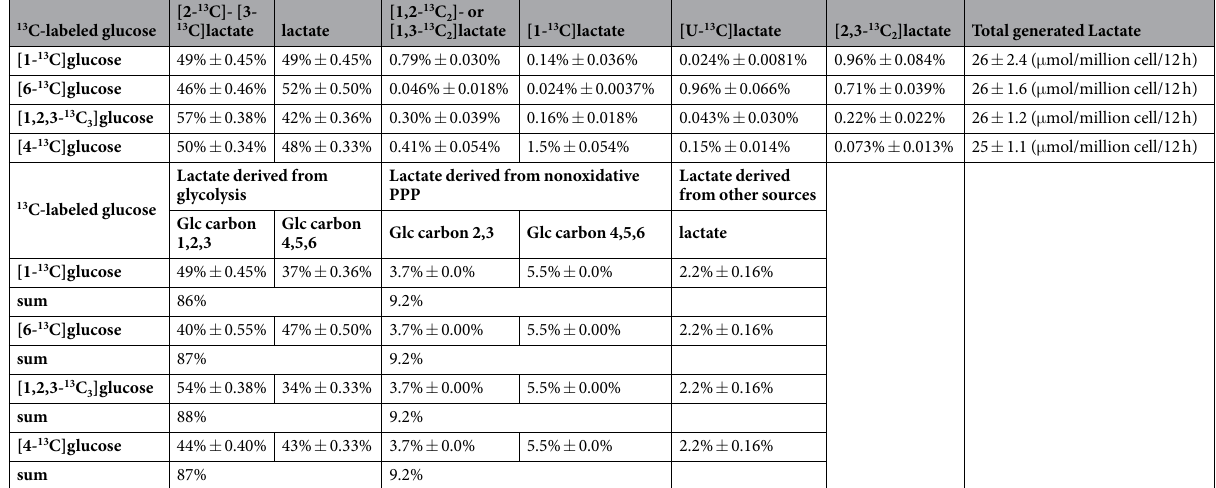
Table 4. The percentage of lactate isotopomers and isotopologues (mean ± SD, n = 12) generated by 4T1, traced by [1- 13 C]-, [6- 13 C]-, [1,2,3- 13 C 3 ]-, and [4- 13 C]glucose (upper part), the percentage of lactate (mean ± SD, n = 12) derived from glycolysis, PPP and other sources (down part). 4T1 cells were incubated in serum-free in a humidified CO 2 incubator and culture supernatant was collected for LC-MS/MS analysis as described in Materials and Methods. The upper part summarizes the percentage of all lactate isotopologues. The down part assigned the percentage of isotopologues that are generated from glycolysis, pentose phosphate pathway, and other sources. Specifically, the percentage of lactate is composed of three parts, from glycolysis, pentose phosphate pathway (calculated based on percentage of [2- 13 C]lactate and [1,2- 13 C 2 ]lactate in Table 3), and other sources (according to percentage listed in Table 1). Data are mean ± SD, n = 12, from 2 independent experiments.